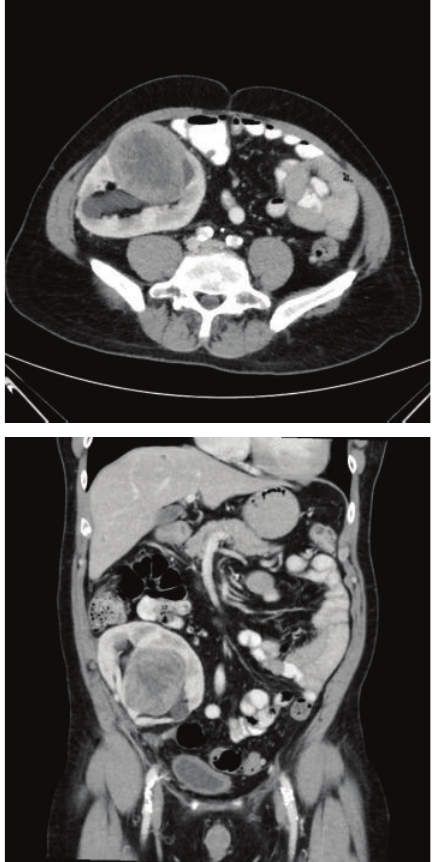
Figure 2: Axial and coronal contrast-enhanced computed tomo- graphic images showing a heterogeneous, well circumscribed, soft tissue mass arising from the midpole of the renal allograft showing minor vascularity and less enhancement compared to surrounding